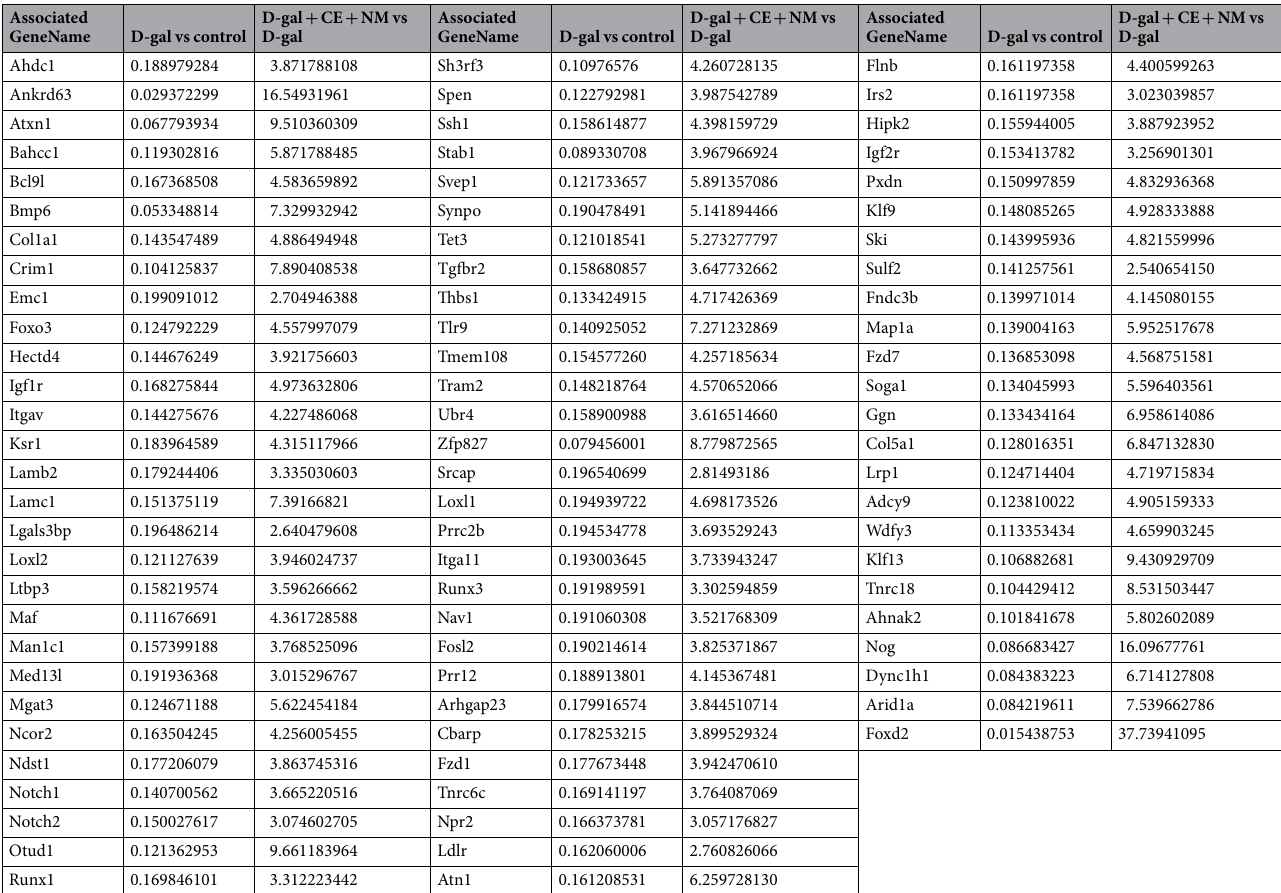
Table 2. The down-regulation of genes in BMSCs of aging rats. Of 326 genes, fivefold change of differential genes expression between control and D-gal